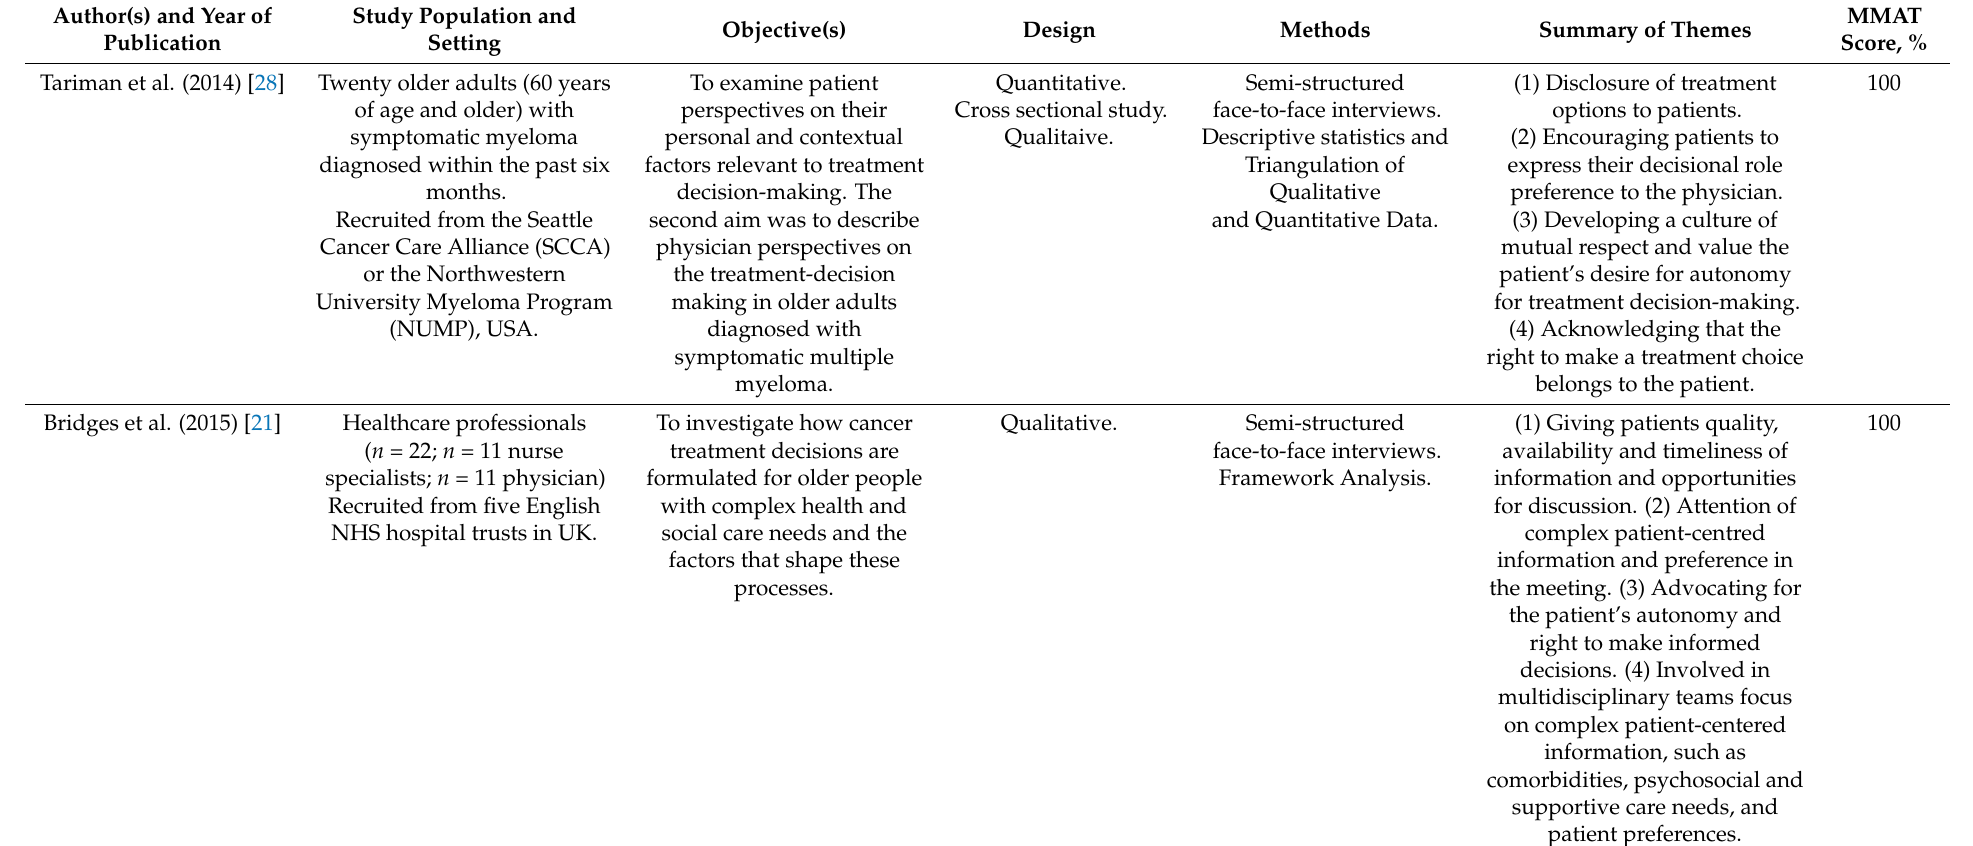
Table 1. Studies included in the